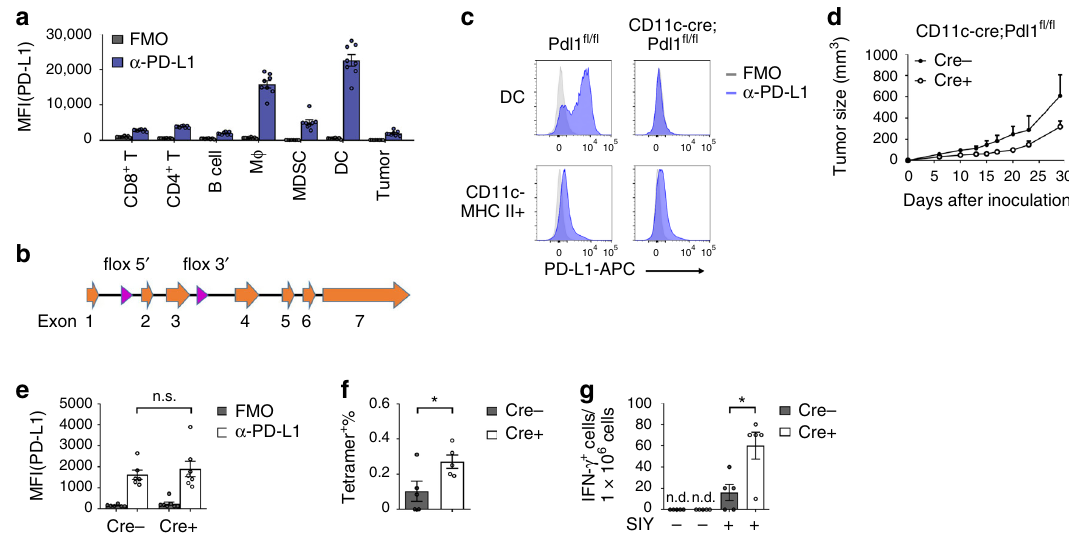
Fig. 1 PD-L1 on DCs is important for T cell priming during antitumor immune responses. a WT B6 mice ( n = 8) were inoculated with 5 × 10 5 MC38 cells and analyzed by fl ow cytometry on day 14 after inoculation. PD-L1 expression levels on CD8 + T (CD3 + CD8 + ), CD4 + T (CD3 + CD4 + ), B (CD19 + ), macrophage (CD11b + F4/80 + ), MDSC (CD11b + Gr-1 + ), DC (CD11c + MHC II + ), and tumor (CD45 − ) cells were shown. FMO, fl uorescence minus one; MFI,